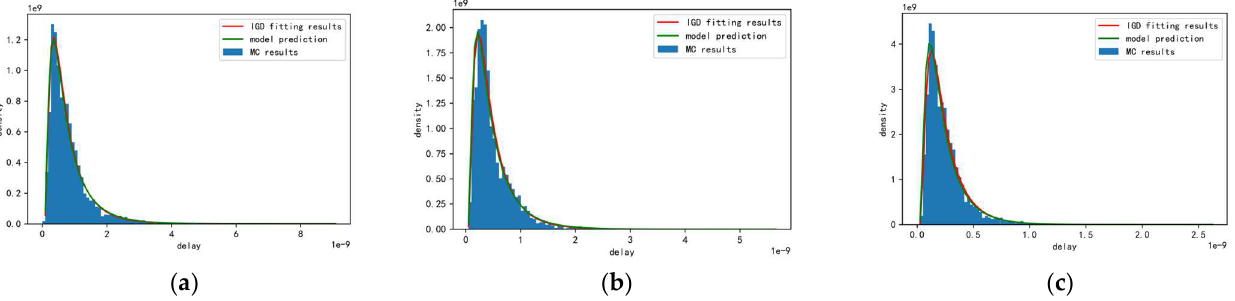
Figure 13. Comparison of PDF curves among MC simulation, IGD fitting, and IGD delay modeling prediction: ( a ) Vgs = 0.25 V; ( b ) Vgs = 0.27 V; ( c ) Vgs = 0.30 V.